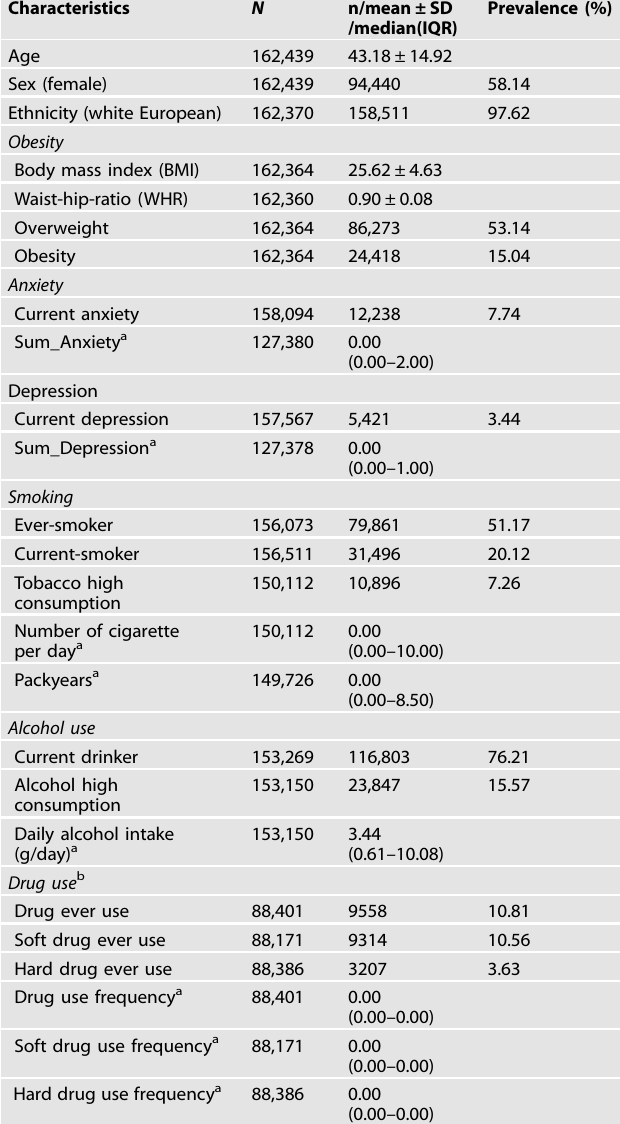
Table 1. Characteristics of participants in